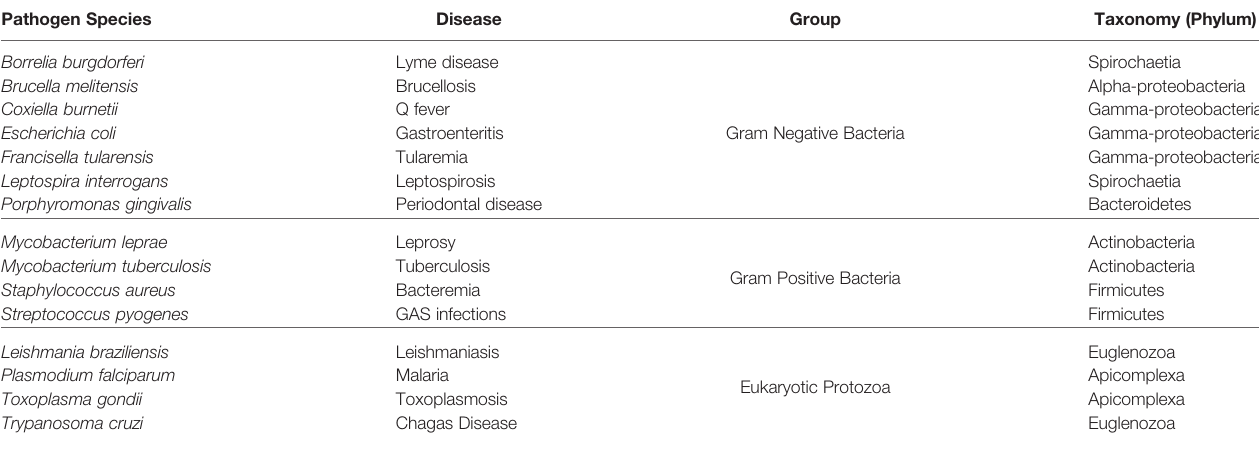
TABLE 1 | List of pathogen species used in this paper. Pathogen